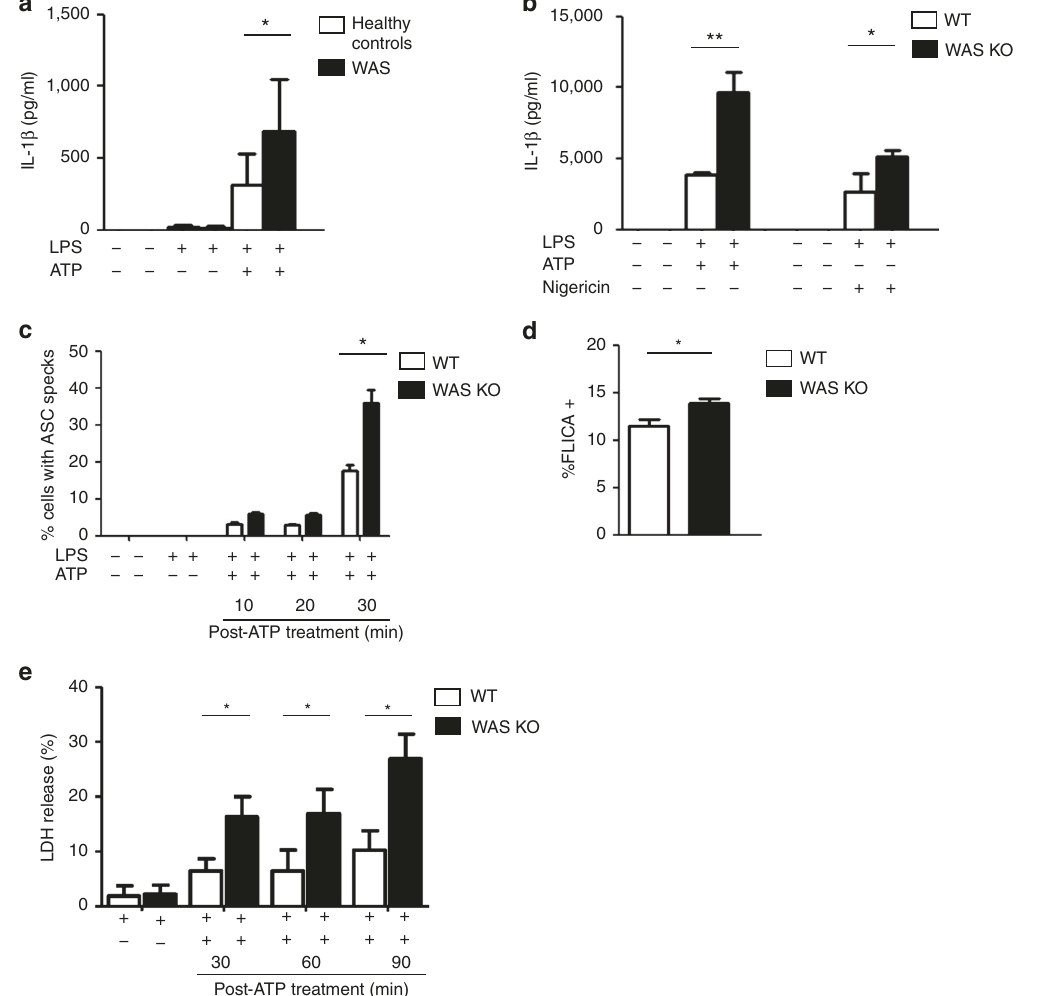
Fig. 1 Increased NLRP3 activation in WASp-de fi cient myeloid cells. a CD14 + monocytes from healthy controls ( n = 6) and patients with classical WAS ( n = 3; Ochs ’ score ≥ 4, and no WASp expression by fl ow cytometry) were primed with LPS (50 ng/ml) for 3 h, followed by ATP stimulation (3 mM) for 30 min. After stimulation, IL-1 β was evaluated in culture supernatants by ELISA. Data presented are mean protein concentration ± SEM performed